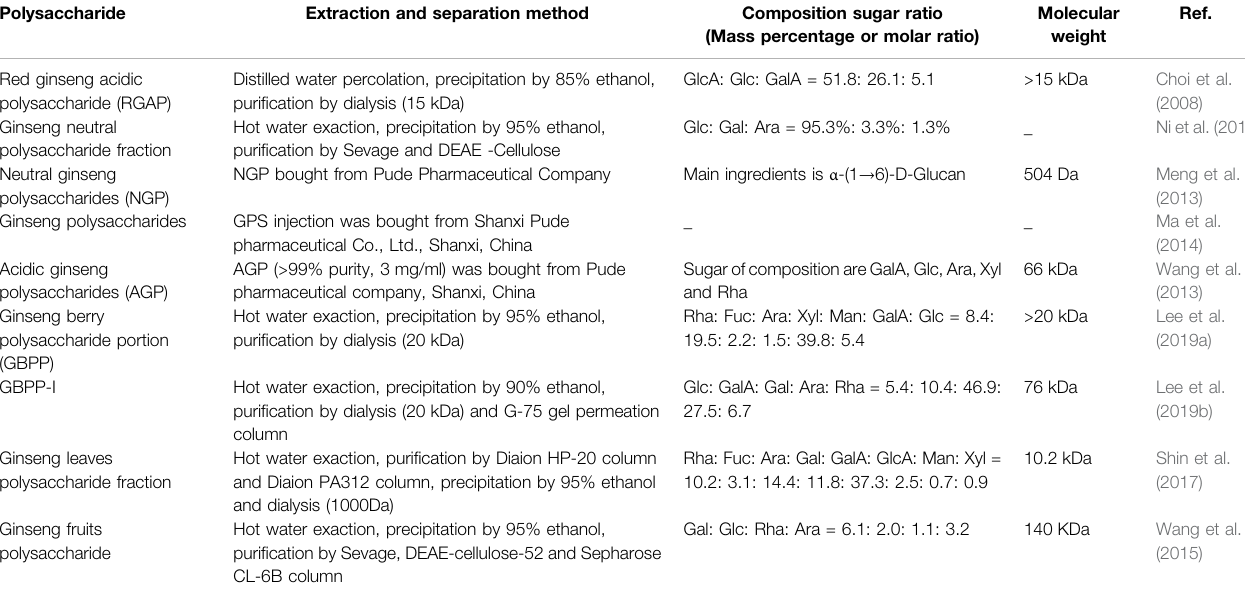
TABLE 4 | Structure and extraction method of polysaccharide from ginseng. Polysaccharide Extraction and separation method Composition sugar ratio